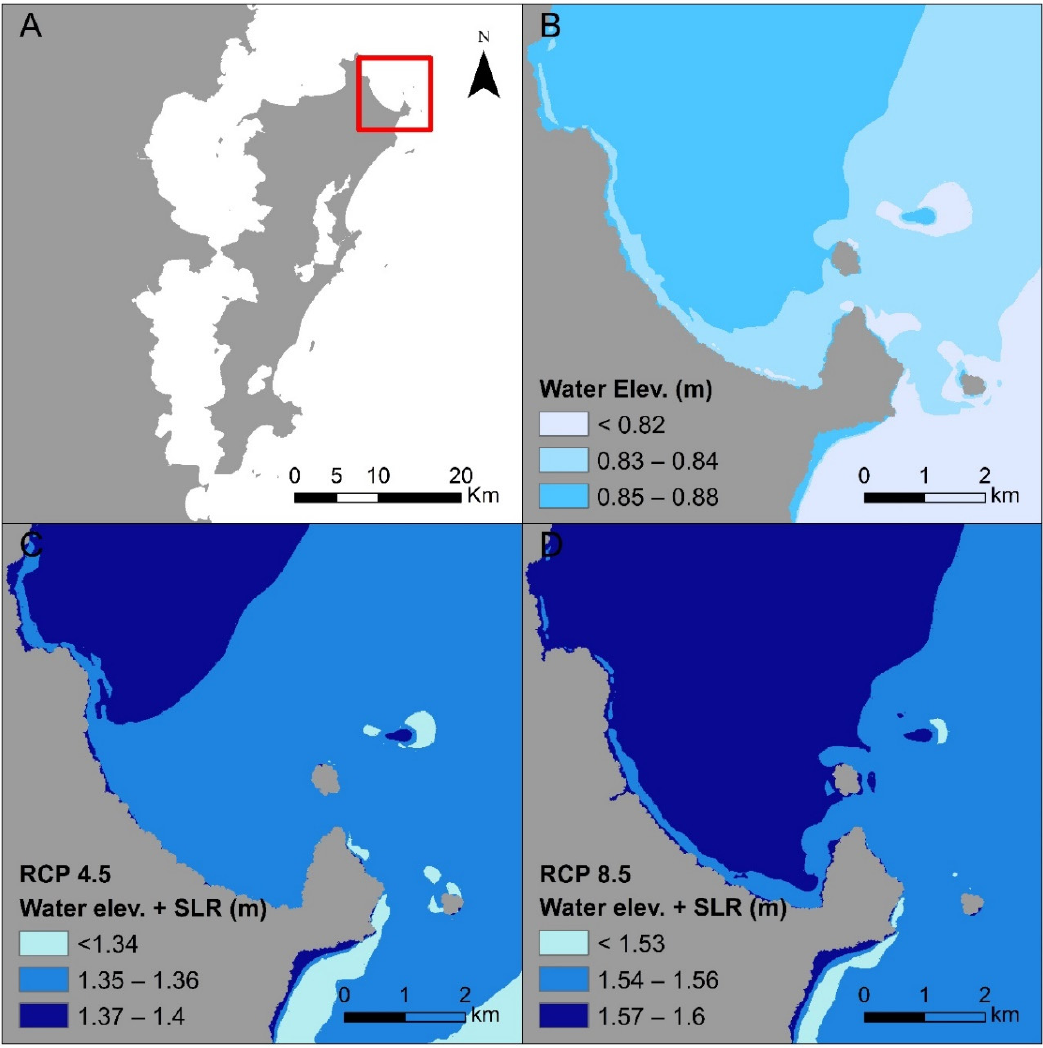
Figure 15. ( A – D ) Sea-level rise scenarios at Ingleses beach, Florianopolis (gray portions represent land).